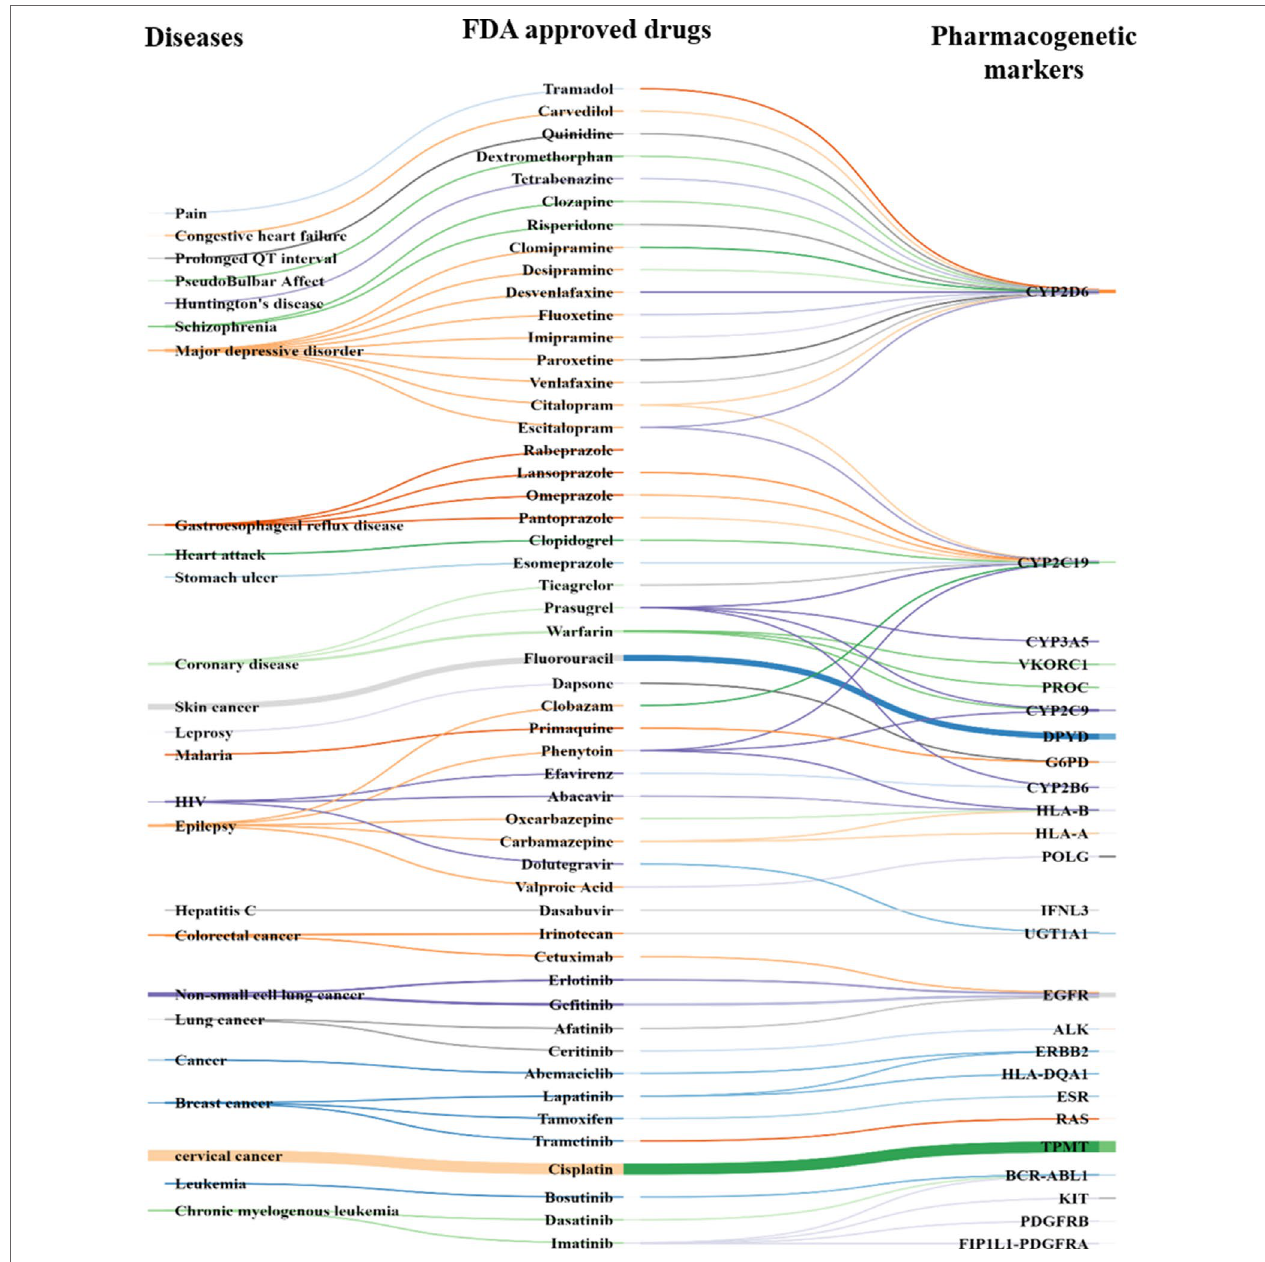
FIGURE 3 | PGx-specific enriched markers other than that mentioned in PharmGKB. Disease ontology (left), FDA-approved drug (middle), and pharmacogenes (right) known (i.e., statistical association in clinical-genetics studies) to alter drug response or efficacy or lead to adverse drug response ( Supplementary Table 9